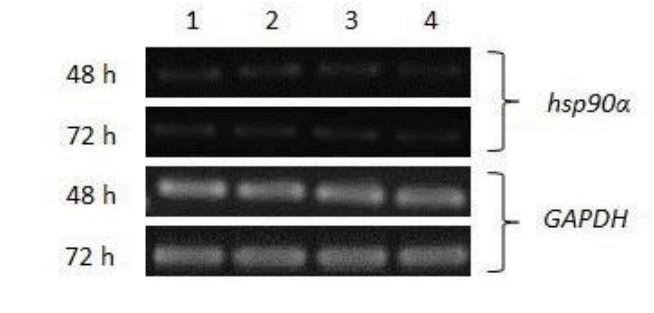
Figure 3 . hsp90 (cid:2) transcription level in SVGp12. mRNA expression levels of hsp90 (cid:2) and GAPDH in SVGp12 cells treated with sihsp90 (cid:2) which targets exon 5 on the hsp90 (cid:2) gene and/or Hsp90 inhibitor 17-AAG were assessed by agarose gel electrophoresis ( A ) and qRT-PCR ( B ), for mRNA gene expression copy numbers after 48 h and 72 h. Lane (1) control; (2) sihsp90 (cid:2) ; (3) 17-AAG; (4) sihsp90 (cid:2) + 17-AAG. sihsp90 (cid:2) represents cells treated with hsp90 (cid:2) specific siRNA. sihsp90 (cid:2) + 17-AAG represent concurrent assays where the cells were treated with 17-AAG and sihsp90 (cid:2) for either 48 h or 72 h. Data values are mean ± SD, n = 3.